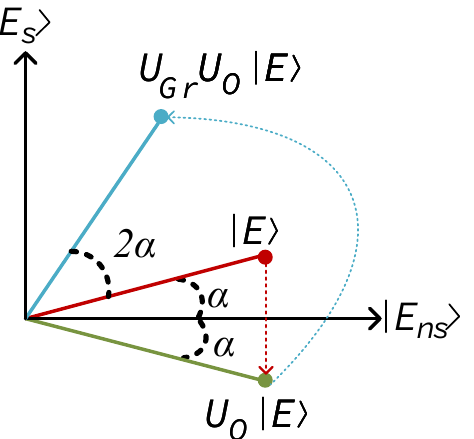
Figure 3. The starting state in a 2D space, which is made by E s and E ns and with the operation of Grover’s operator, and more details can be found in